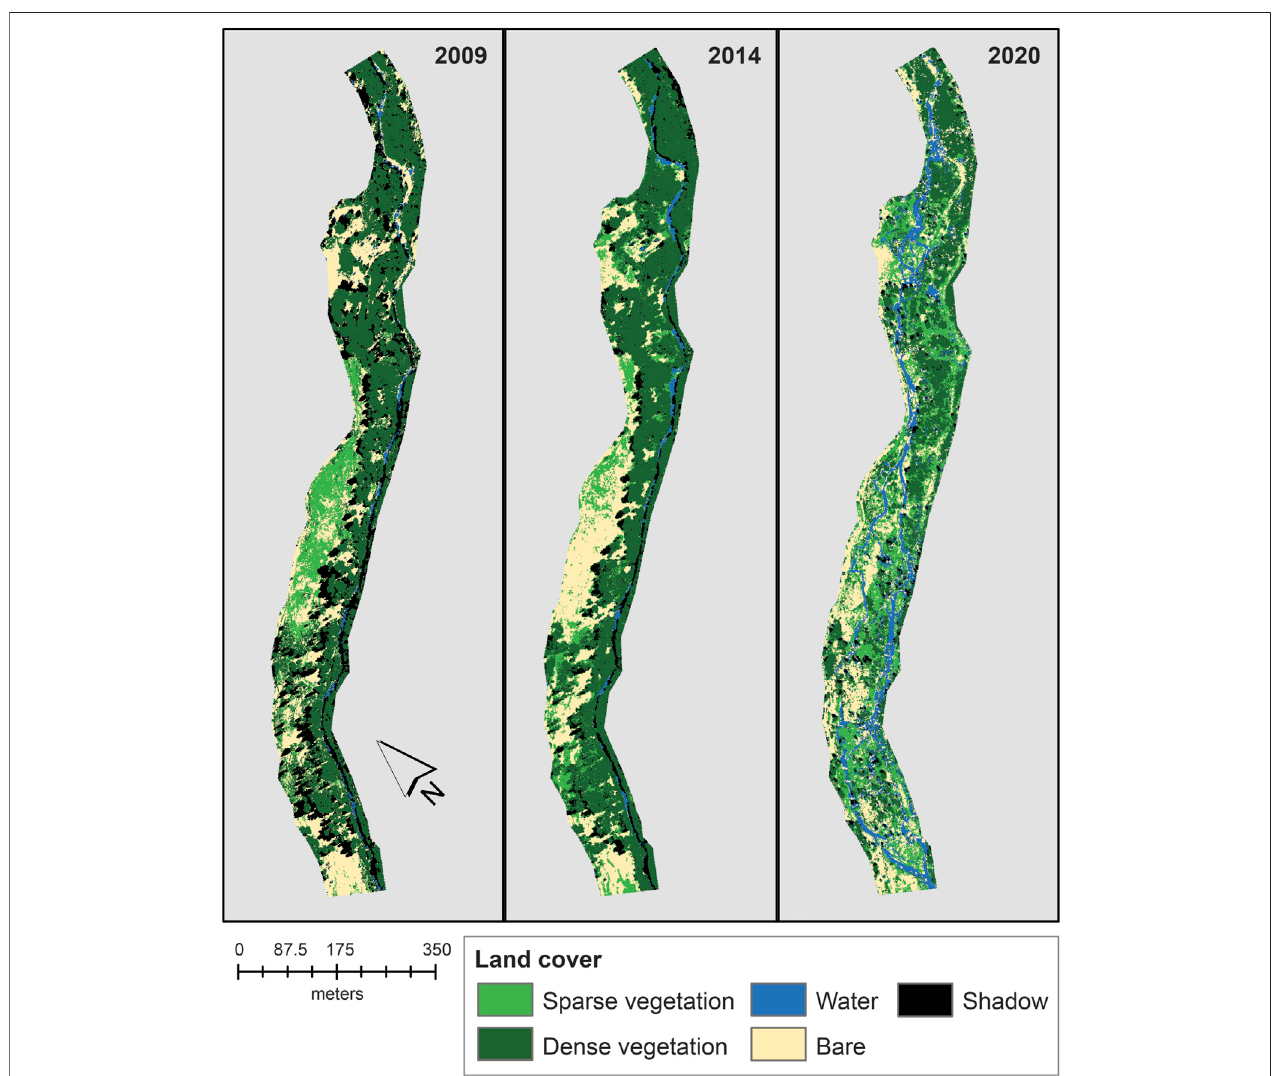
FIGURE 10 | Isocluster unsupervised classi fi cation of surface vegetation at Whychus Canyon Preserve Phase 1 site using National Agricultural Imagery Program NDVI datasets. Restoration occurred at this site in 2016.